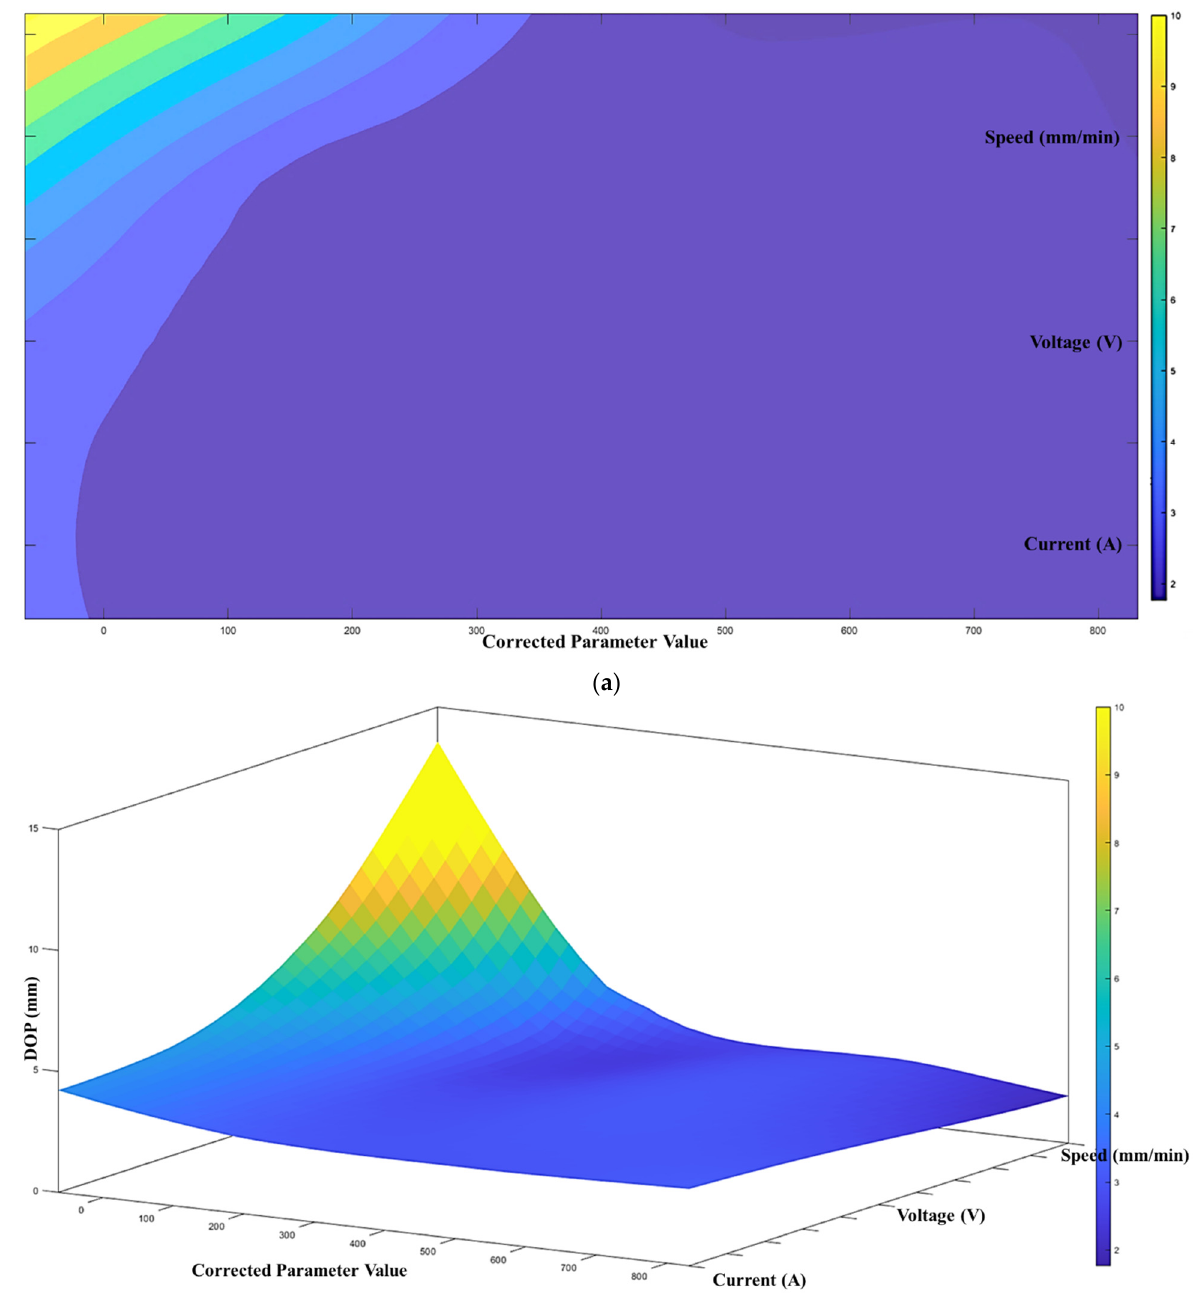
Figure 9. ( a ) Process-quality model (DOP) using current, voltage, and speed (contour), ( b ) process-quality model (DOP) using current, voltage, and speed (3D).